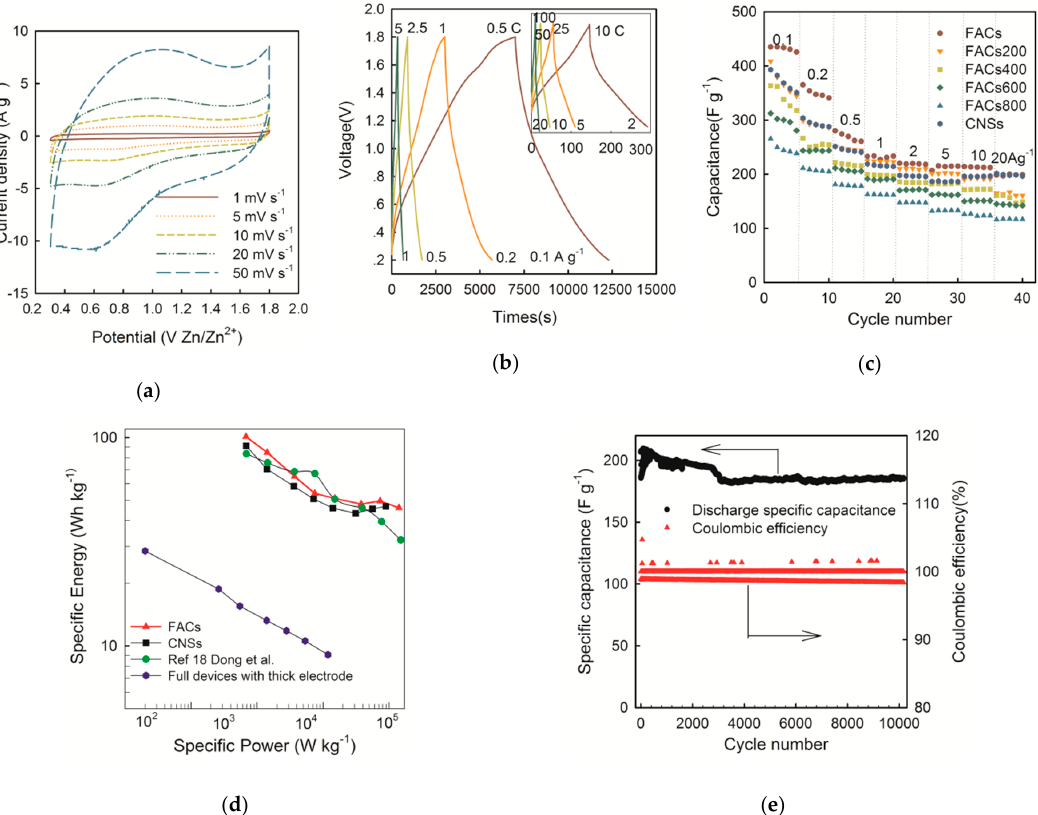
Figure 5. ( a ) CV curves of the FACs-based Zn-ion hybrid SC obtained using the carbon positive electrode as working electrode, and the pure Zn foil as both the counter and reference electrodes at various scan rates of 1–50 mV s − 1 and 0.3 to 1.8 V vs. Zn / Zn + . ( b ) Galvanostatic charge / discharge (GCD) curves of FACs-based Zn-ion hybrid SC at low current densities of 0.1, 0.2, 0.5, and 1 A g − 1 and (insert) high current densities of 2, 5, 10, 20 A g − 1 . ( c ) Rate capability: current density versus specific capacitance for the six samples. ( d ) Gravimetric Ragone plots of the Zn-ion hybrid SCs in aqueous electrolyte based on the mass of carbon positive electrode materials (FACs and CNSs) in this work, compared to the reported work by Dong et al. [18]. The estimated values of full device with thick electrode (120 μ m) are also given. ( e ) Cycling stability of the FACs-based Zn-ion hybrid SC at 2 A g − 1 for 10,000 cycles of charge-discharge.